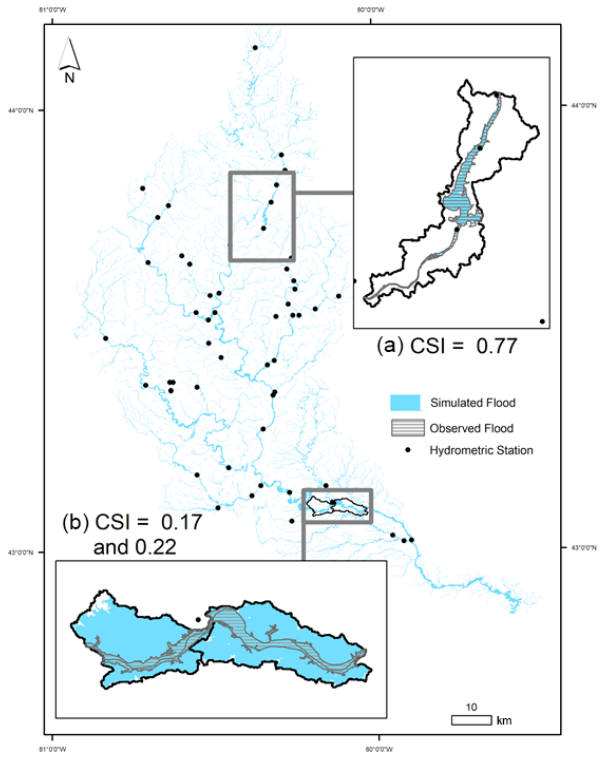
Figure 9. Observed and simulated flood extents – Ottawa River wa-